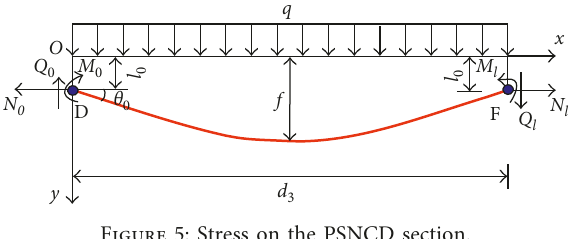
Figure 5: Stress on the PSNCD section.